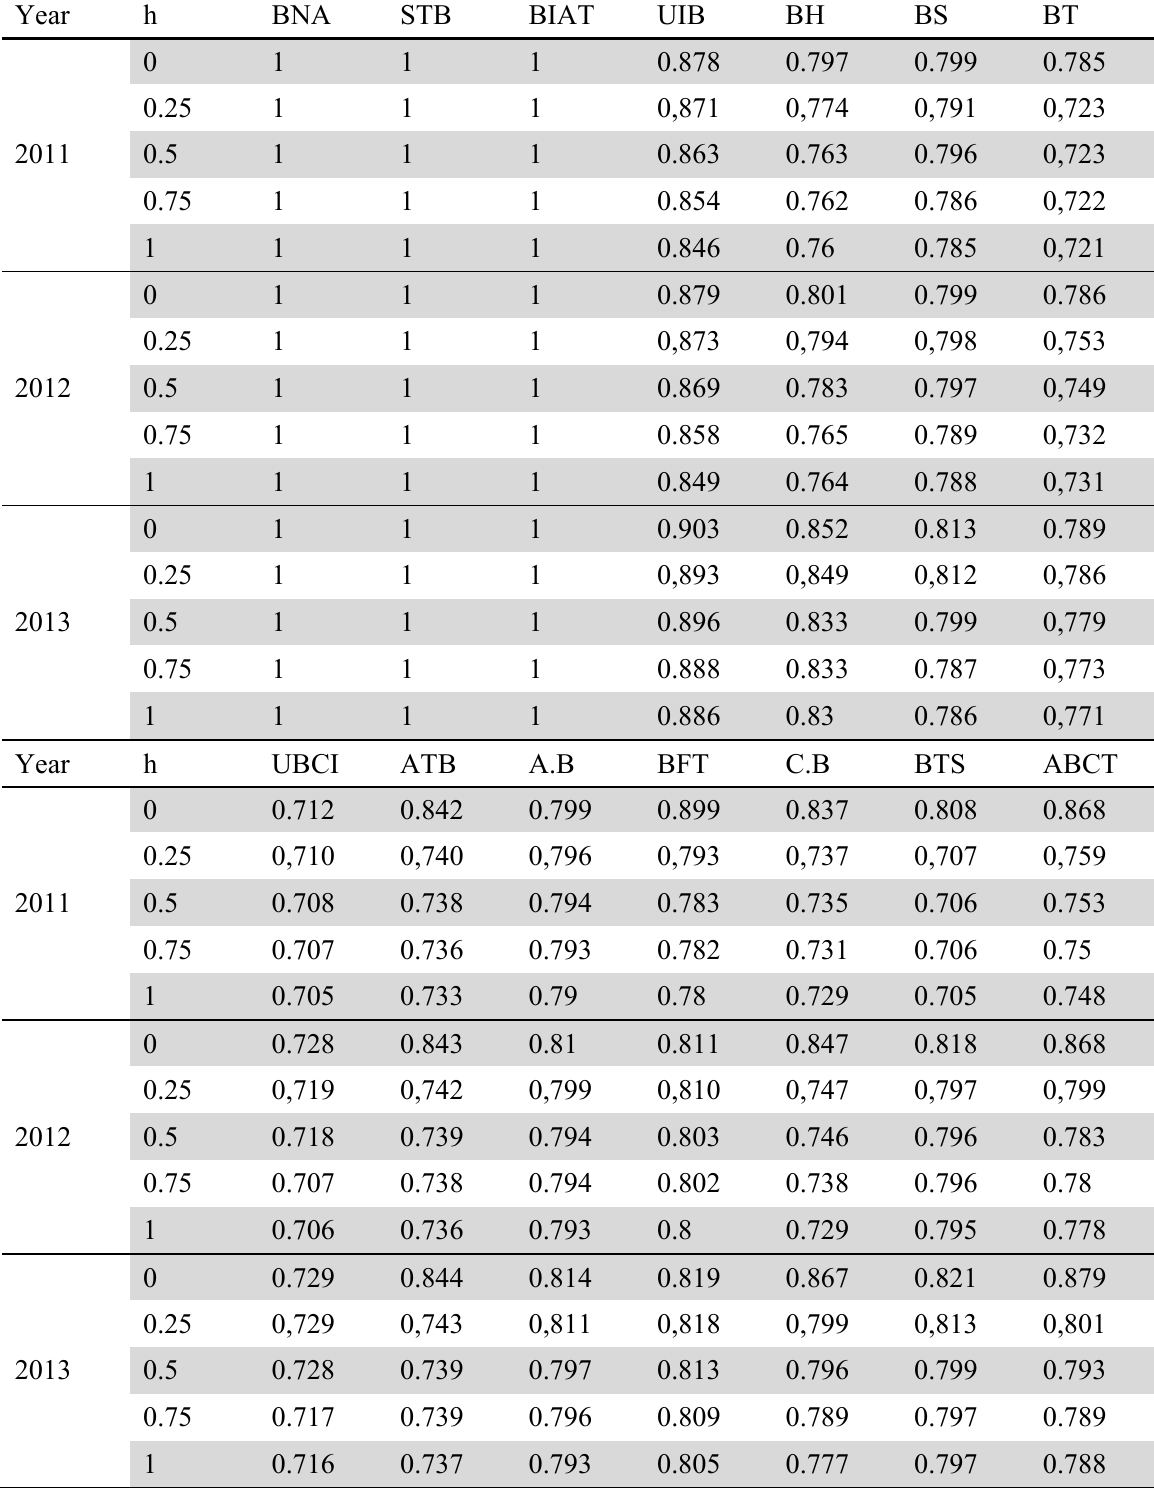
Efficiency scores obtained by the BRONF